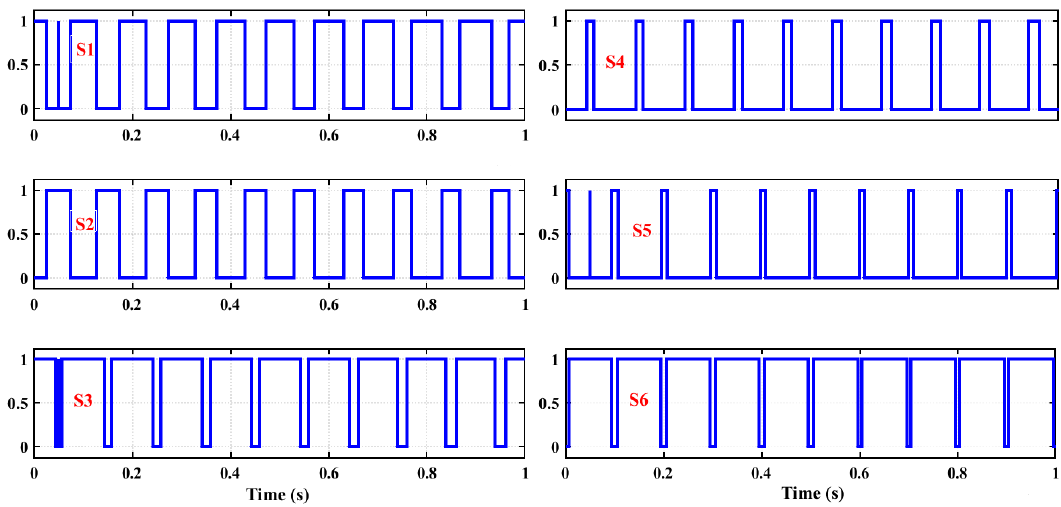
Figure 2. Proposed modulation scheme.